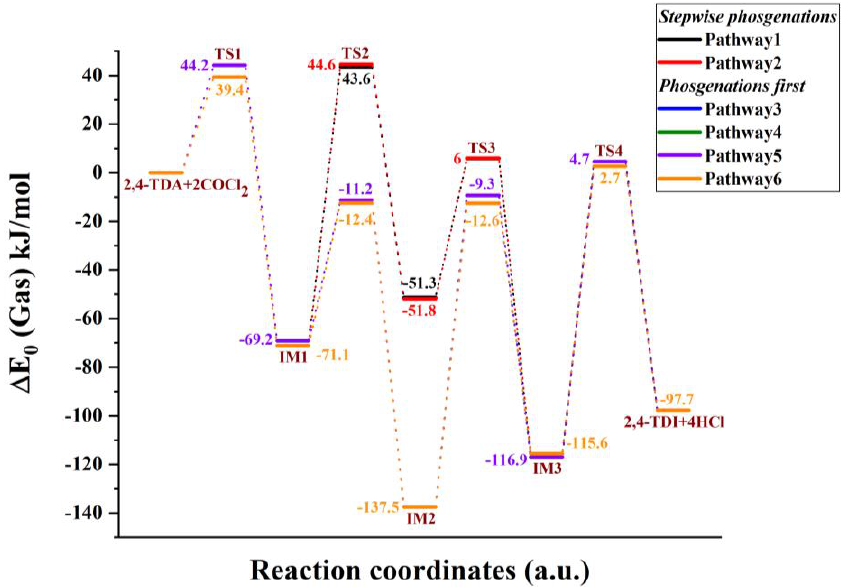
Figure 3. G3MP2B3 energy profile (zero-point corrected) for the phosgenation of 2,4-TDA in the gas phase.